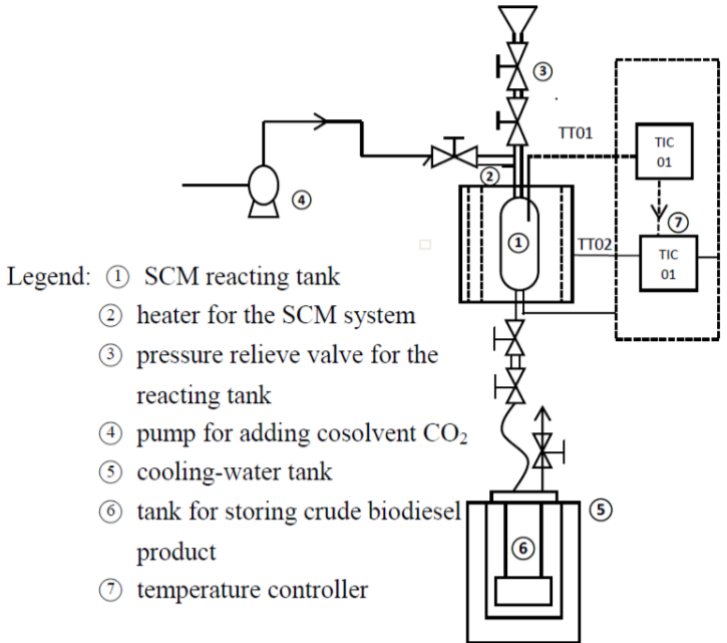
Figure 1. Experimental setup of the supercritical methanol transesterification system for the production of biodiesel from high-acid